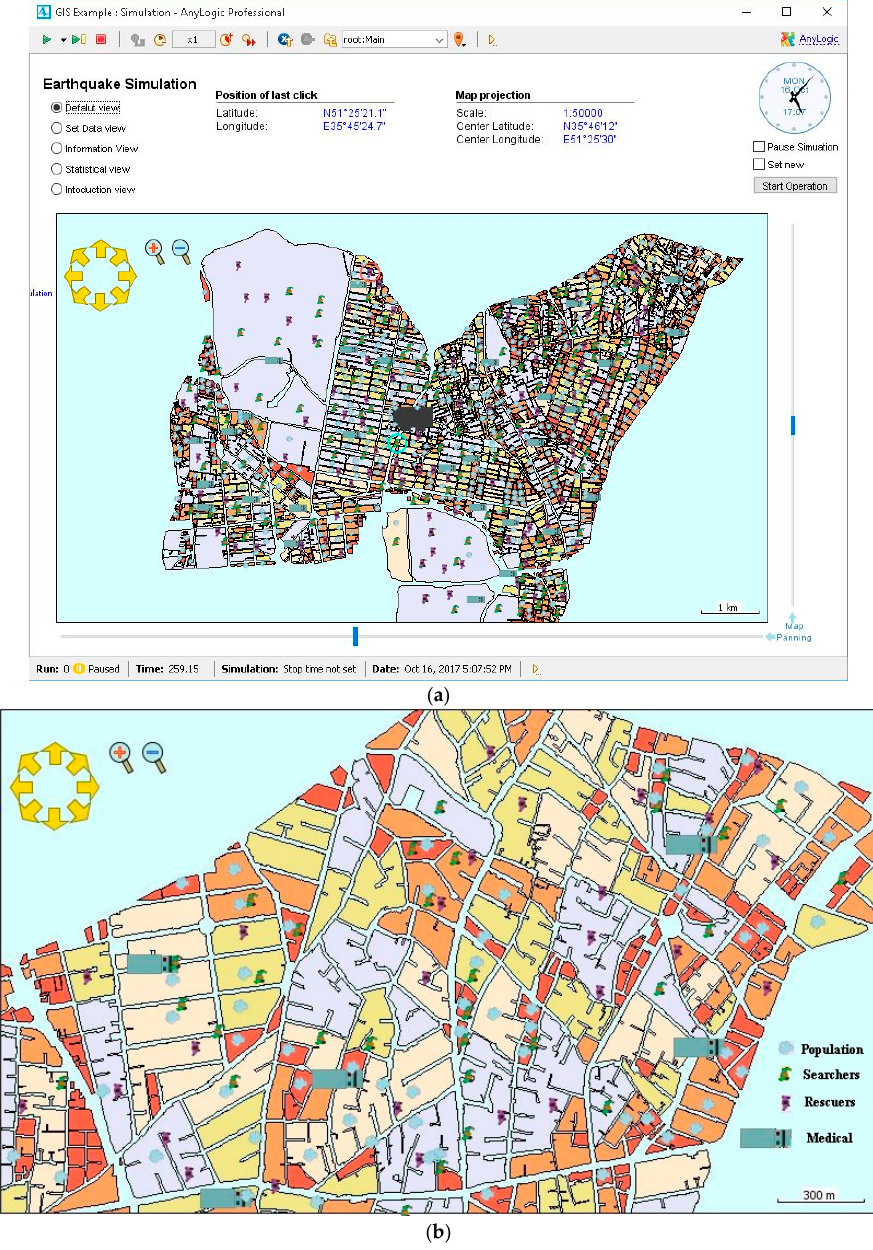
Figure 5. An overview of simulated system: ( a ) a view of USAR simulator, ( b ) Distribution of agents during the rescue and search process.